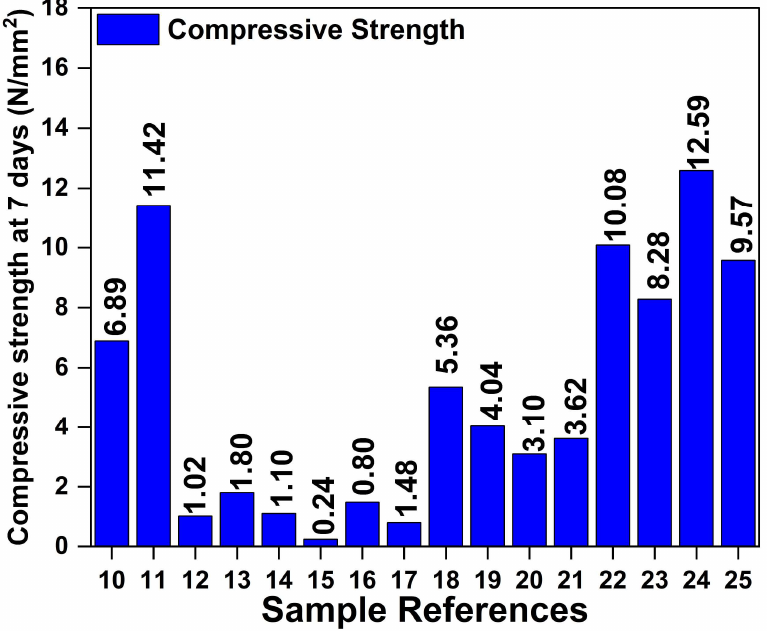
Figure 2. Compressive strength at 7 days of curing age—Stage 2.